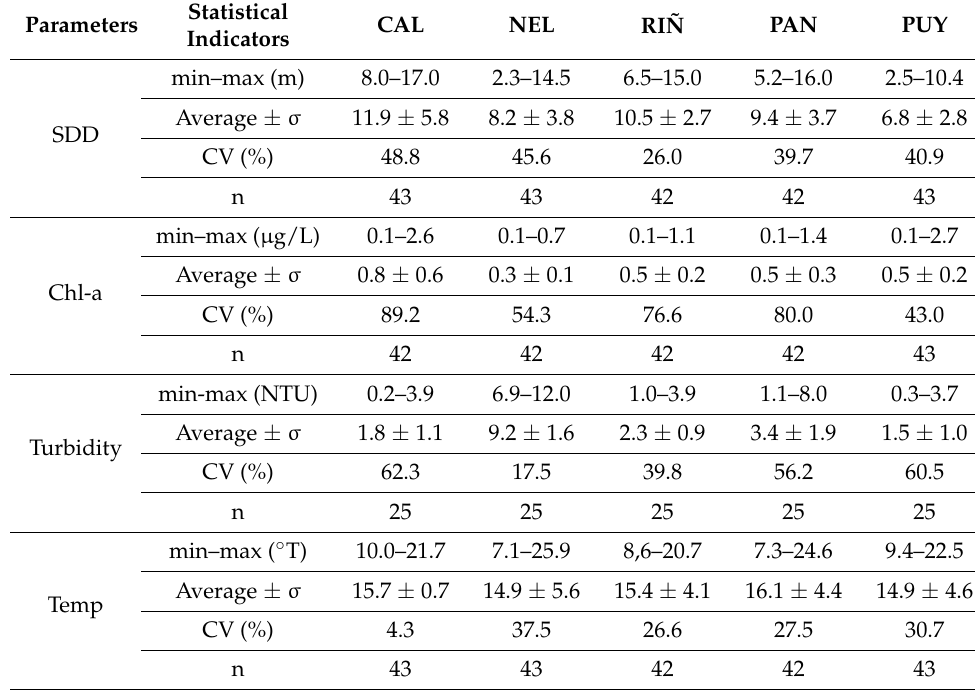
CV—coefficient of variation, n—data number, and σ —standard